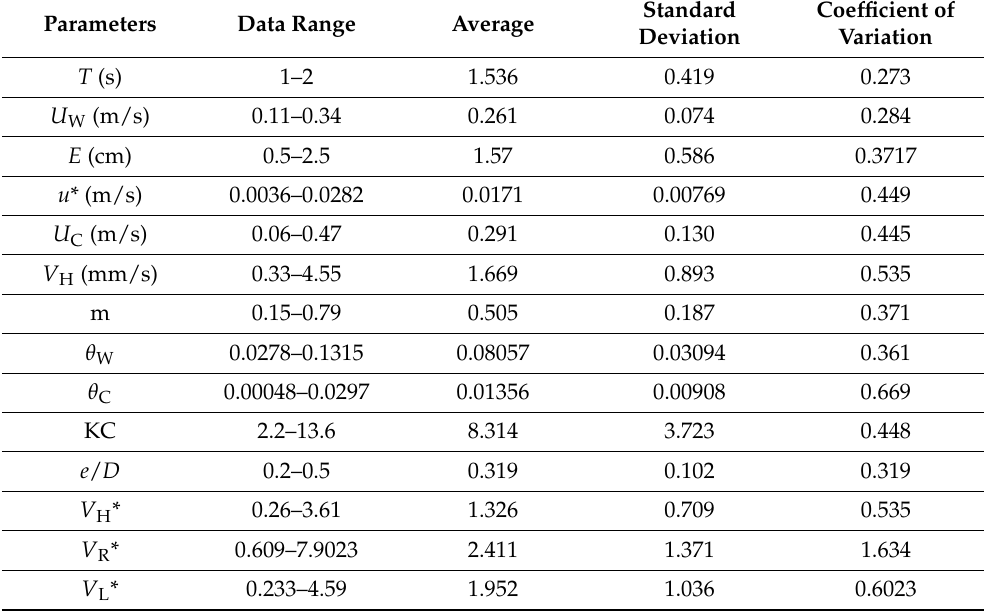
Table 2. Statistical descriptions of